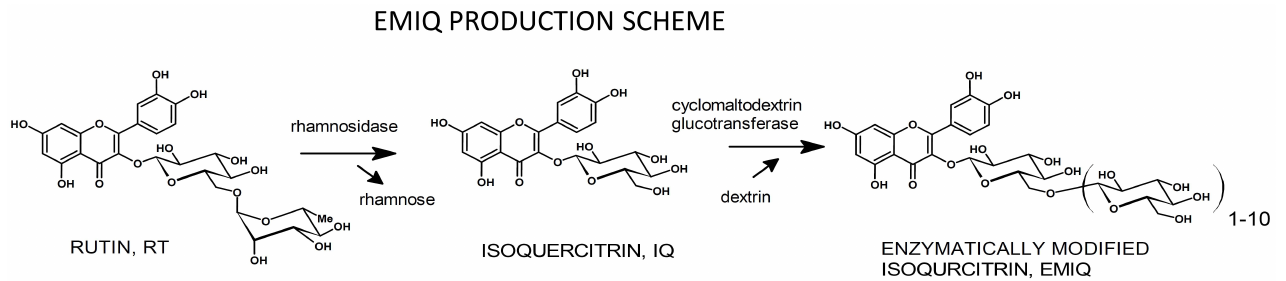
Figure 1. A s implified scheme for EMIQ production. RT obtained from natural sources is transformed using bacterial enzymes first into IQ and then into isoquercitrin oligoglucosides with 1 to 10 α-glucosyl moieties. For more details, see the manuscript text.